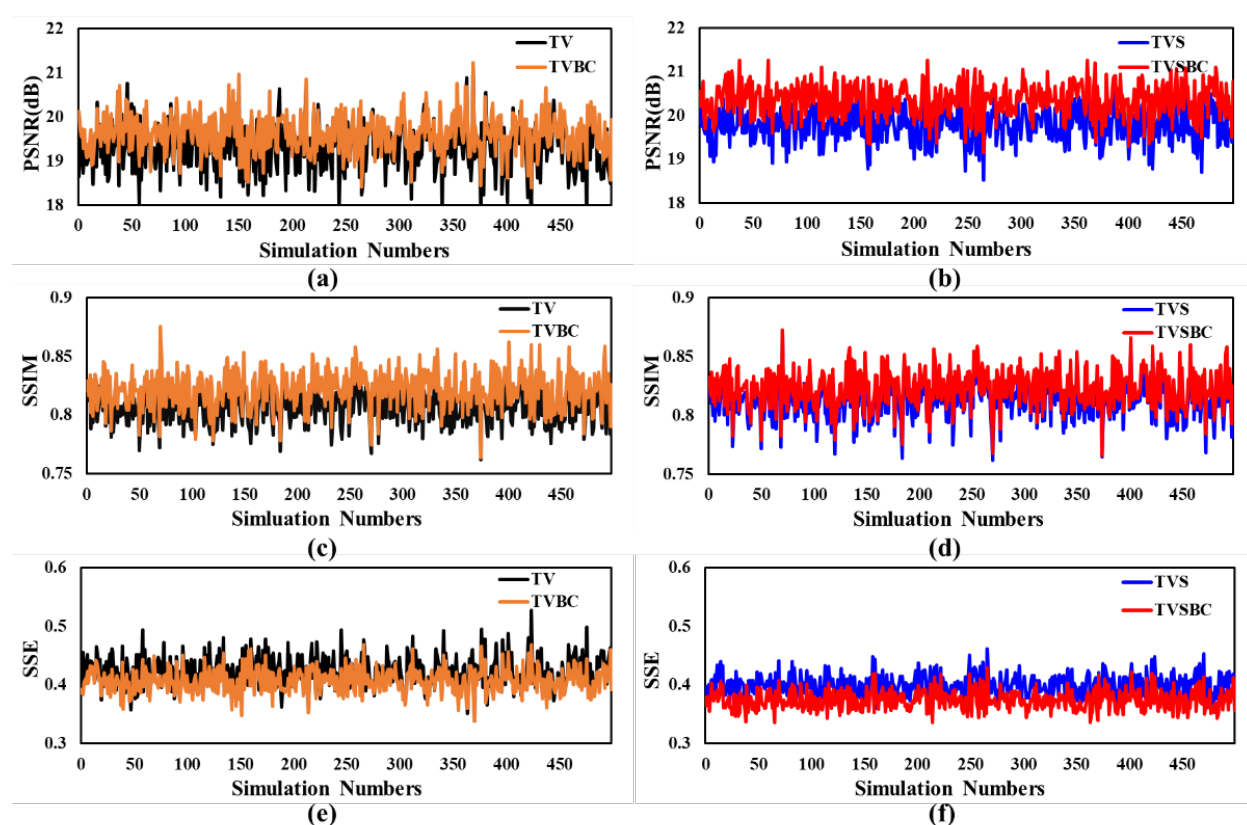
Figure 9. PSNR, SSIM, and SSE results when simulation SNR = 15 dB. ( a ) PSNR for TV and TVS. ( b ) PSNR for TVS and TVSBC. ( c ) SSIM for TV and TVS. ( d ) SSIM for TVS and TVSBC. ( e ) SSE for TV and TVS. ( f ) SSE for TVS and TVSBC. Table 3. Mean PSNR (dB), SSIM and SSE results with 500 simulations of Figure 8. Methods